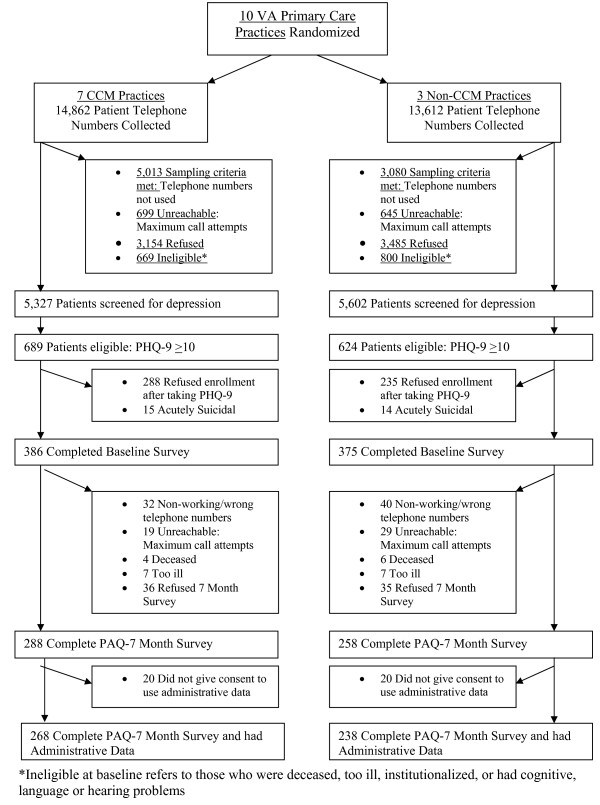
Sampling flow chart.